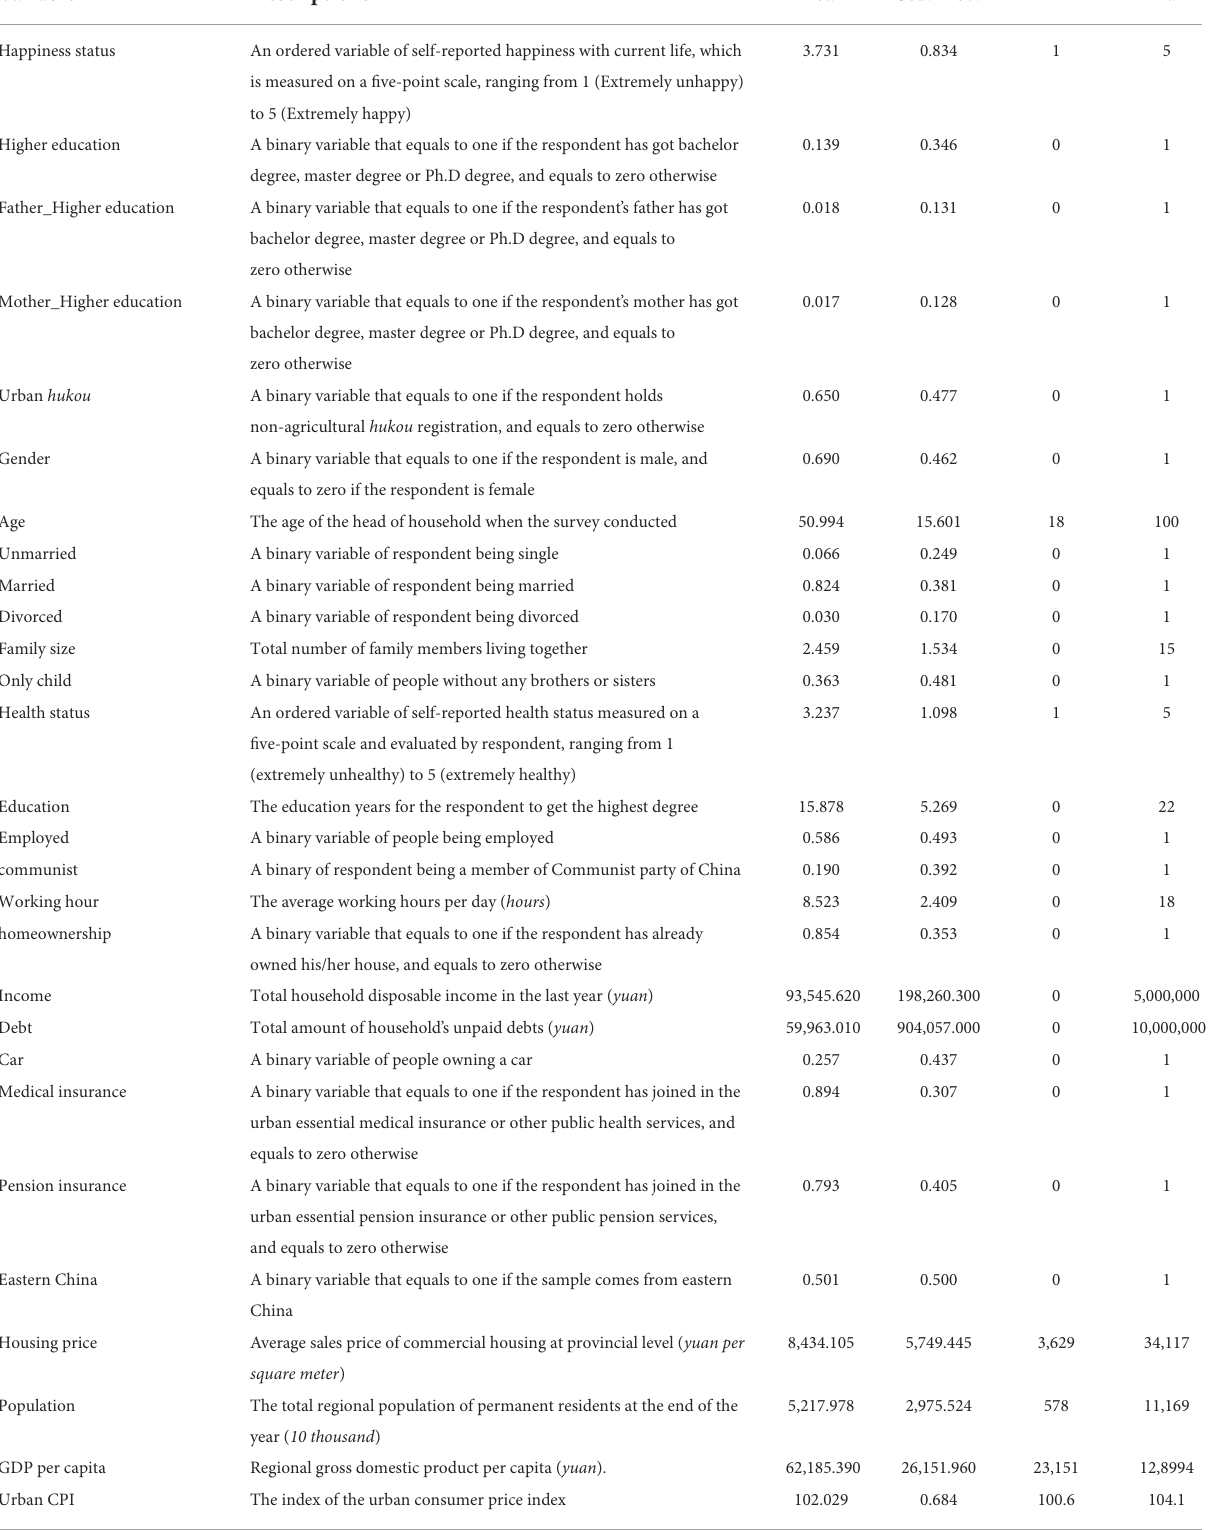
TABLE 1 Variable description and summary